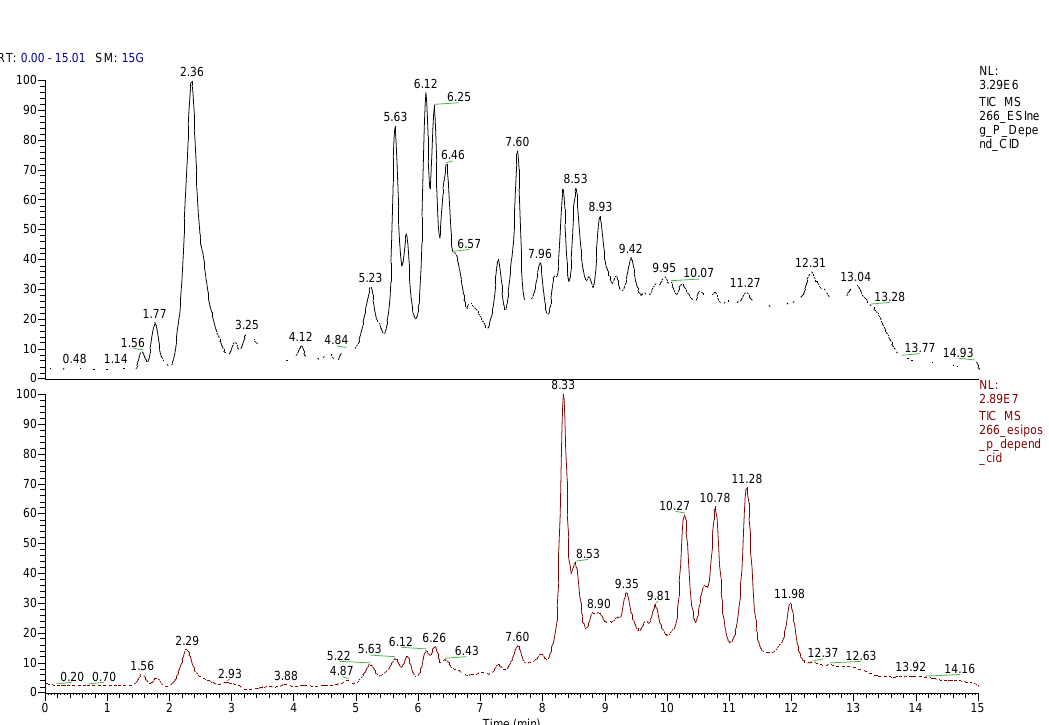
Figure 3. Positive and negative mode TIC spectrum for peumo. TIC of peumo extract is shown in negative and positive